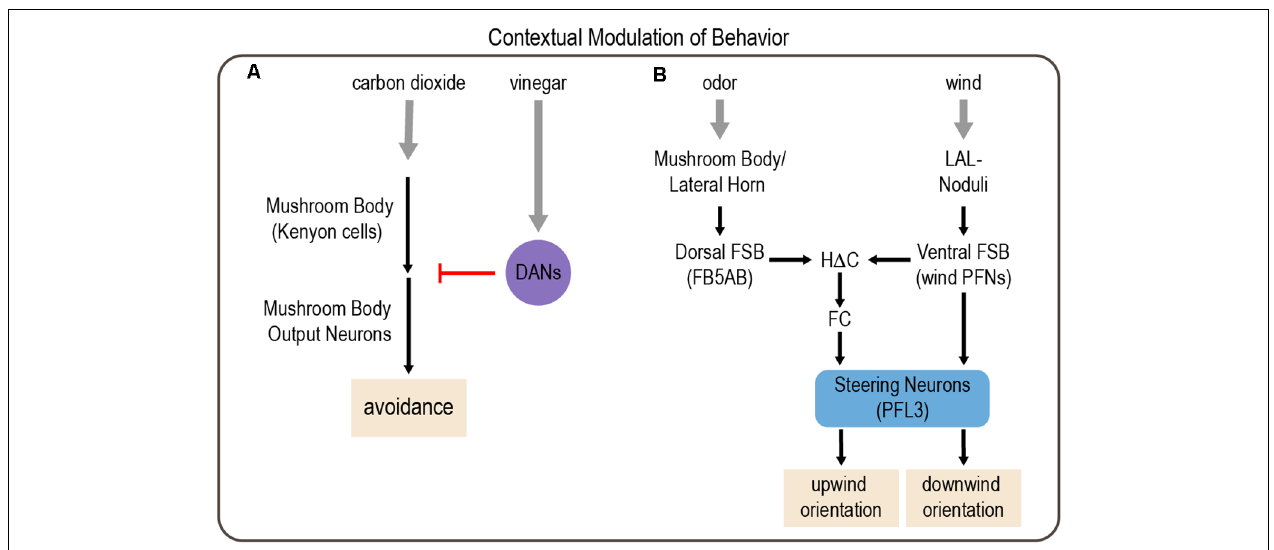
FIGURE 5 | Examples of modulation of behavior by environmental context involving integration of multiple sensory cues. (A) Context-dependent responses to carbon dioxide depend on the mushroom body (MB). Kenyon cells (KCs) in the MB are activated by carbon dioxide, which activates MB output neurons (MBONs) to drive avoidance responses. However, the presence of vinegar activates subsets of DANs, which inhibit MBON activation to reduce carbon dioxide avoidance. (B) Odor and wind cues are processed by parallel pathways that are integrated in the FSB to drive wind orientation. Drosophila typically orient downwind from a wind source. However, in the context of an appetitive odor cue, this behavior reverses, and flies orient upwind. Gray arrows depict sensory input; black arrows depict neural circuit connectivity; red arrow depicts inhibitory